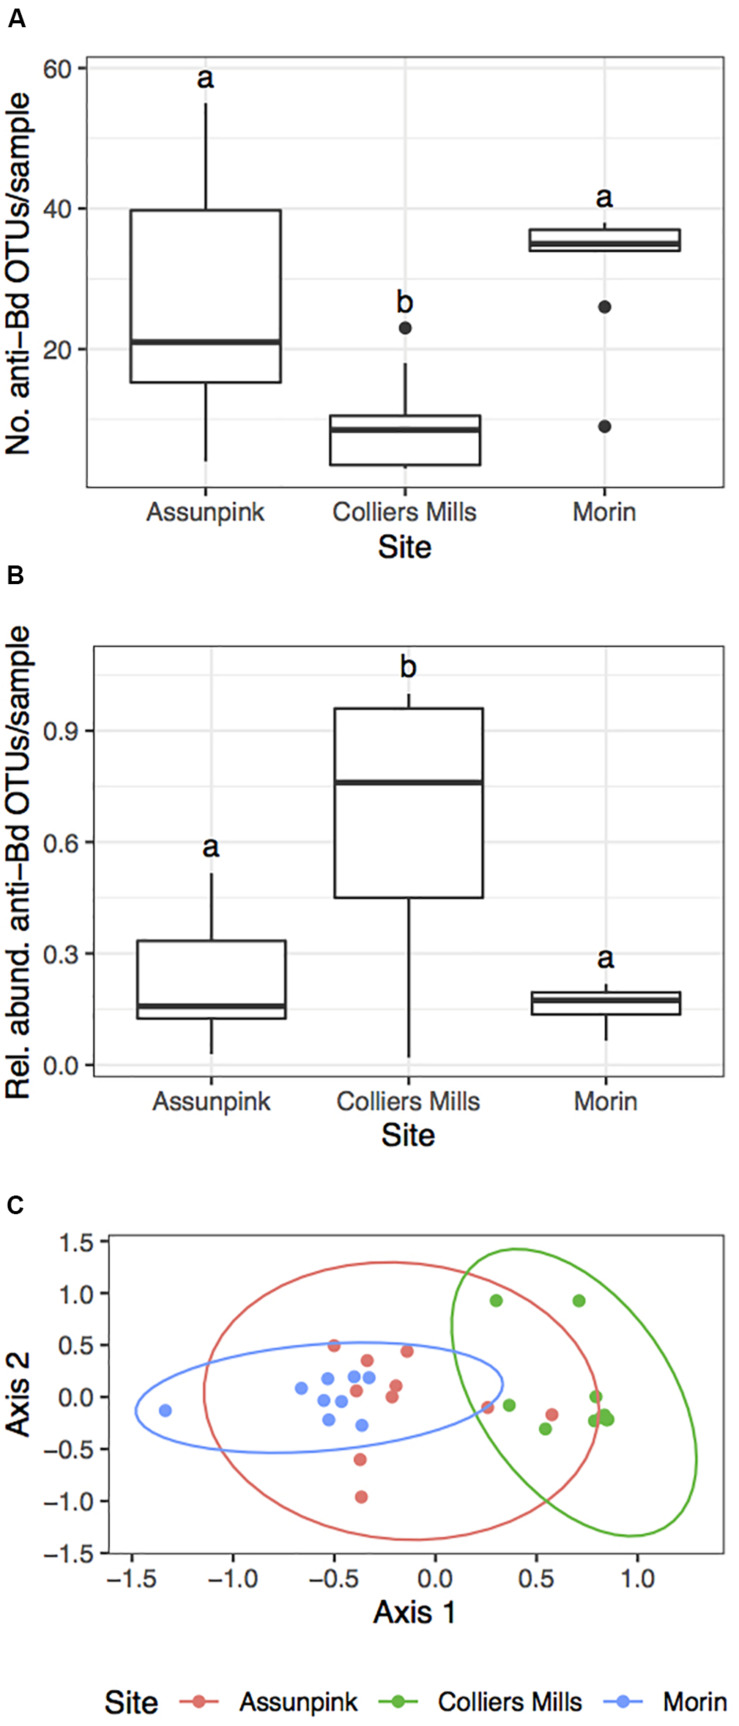
Summary of putative anti-Bd OTU community metrics among three green frog populations. The (A) number, (B) relative abundance, and (C) beta diversity (NMDS: k = 2, stress = 0.151) of putative anti-Bd OTUs varied significantly among green frog populations. Letters in (A) and (B) denote significant differences between sites (FDR-corrected p < 0.05). Pairwise PERMANOVAs indicated that there were significant differences in anti-Bd beta diversity between all site pairs (p < 0.05).